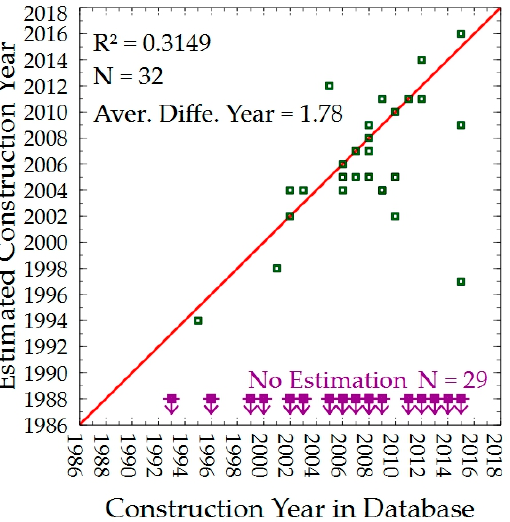
Figure 19. Comparison of the database and estimated years of construction of the 61 bridges. Plotted